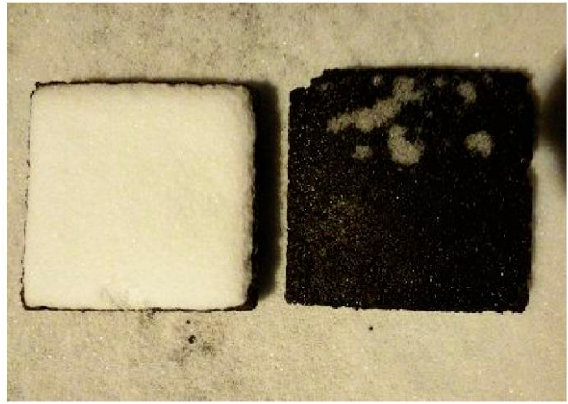
Figure 9. Melting snow text.